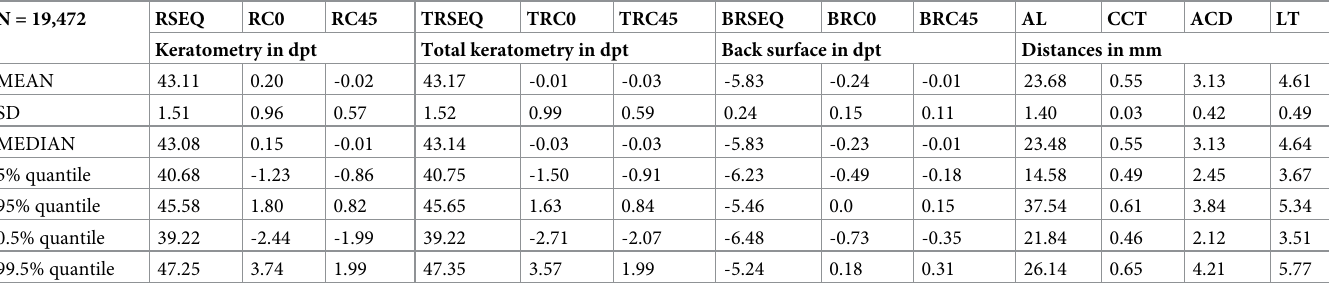
RSEQ, RC0 and RC45 refer to the power vector components of keratometry expressed in equivalent power and projection of the astigmatism to the 0/90˚ and 45˚/135˚ meridian, TRSEQ, TRC0 and TRC45 to the power vector components of total keratometry TK, and BRSEQ, BRC0 and BRC45 to the power vector components of the corneal back surface. MEAN, SD, and MEDIAN refer to the mean value, standard deviation and median value, and 5% / 9% quantiles and 0.5% / 99.5% quantiles to the 90% and 99% confidence interval,